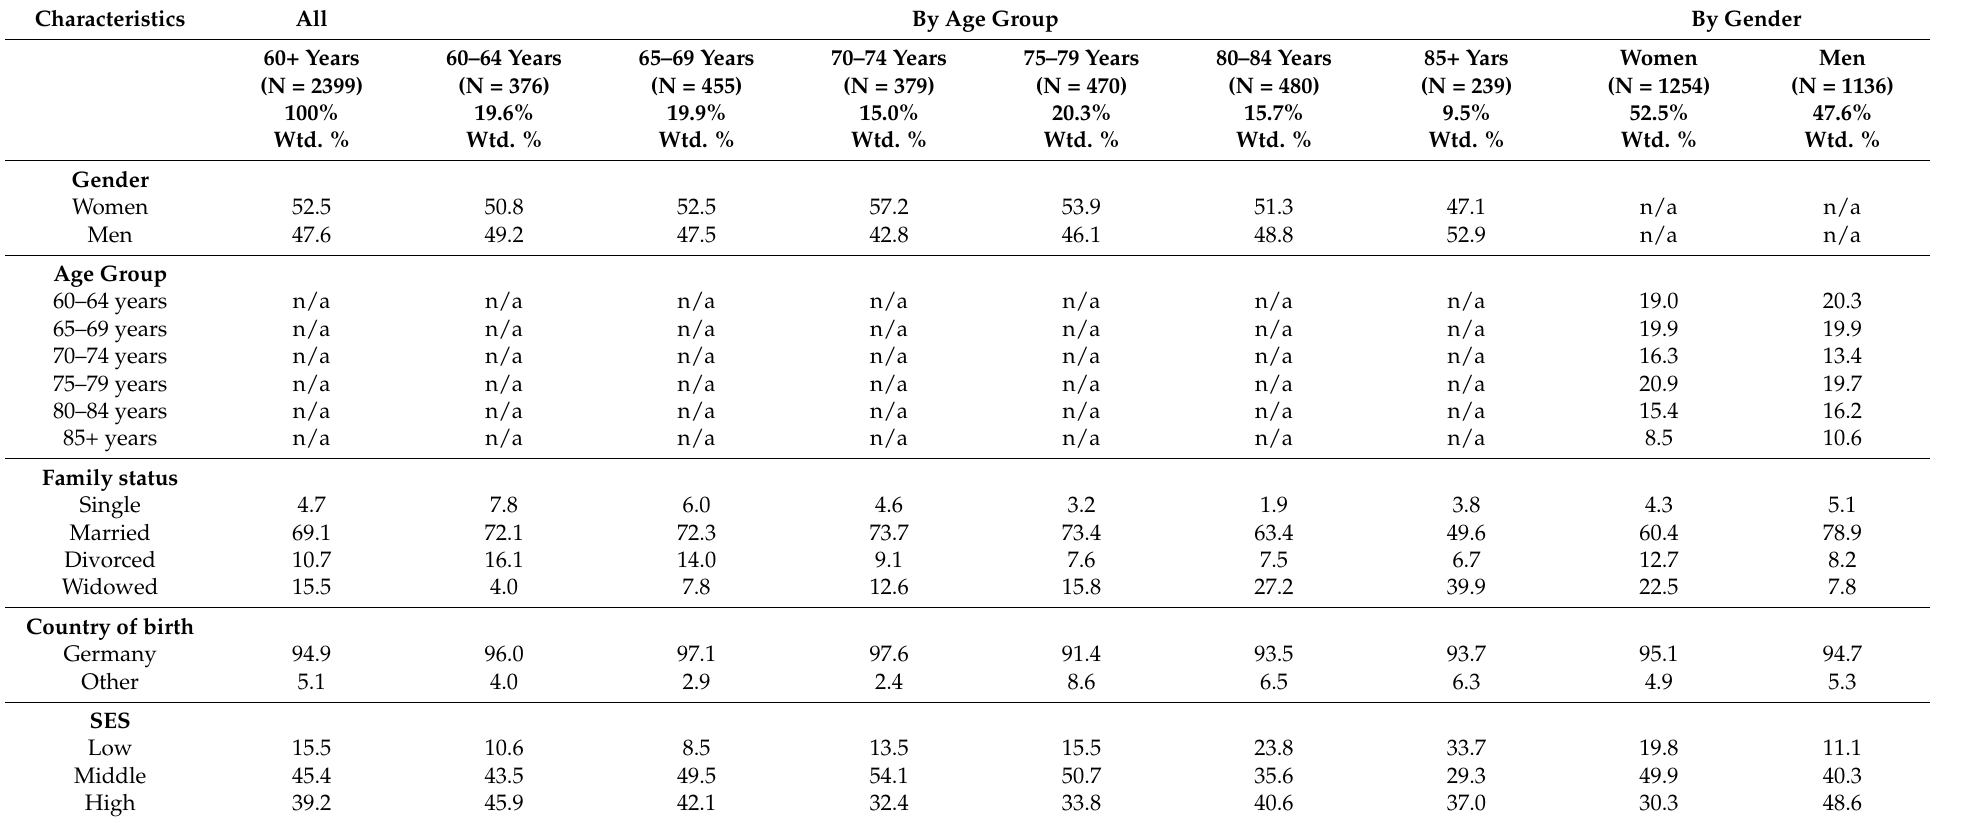
Table 2. Characteristics of survey respondents, after weighting, by age group and